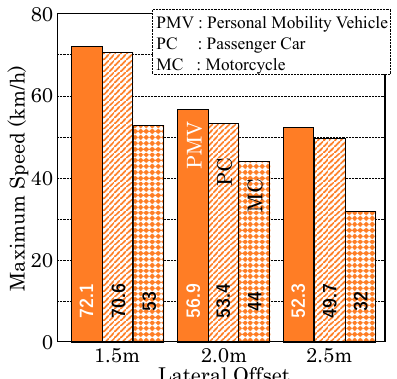
Figure 23. Comparison of capabilities on obstacle avoidance.